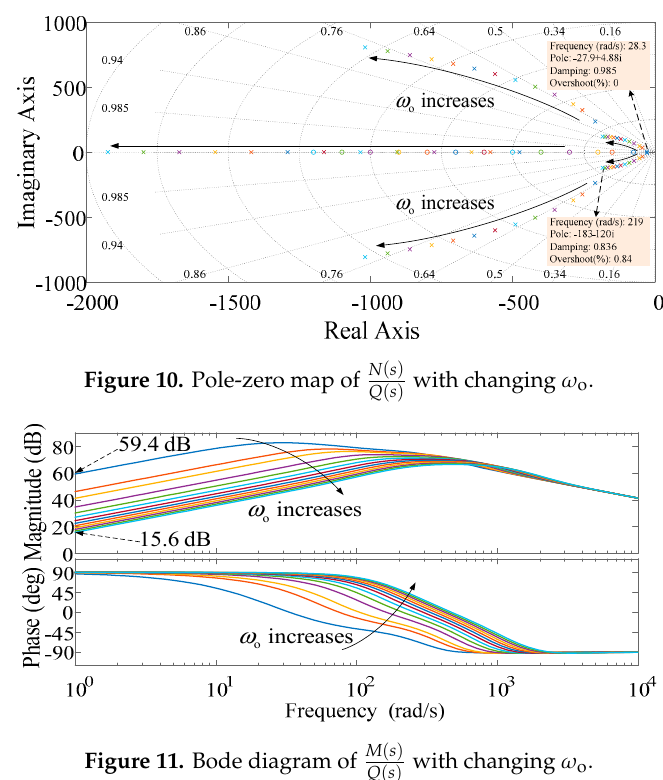
Figure 11. Bode diagram of M